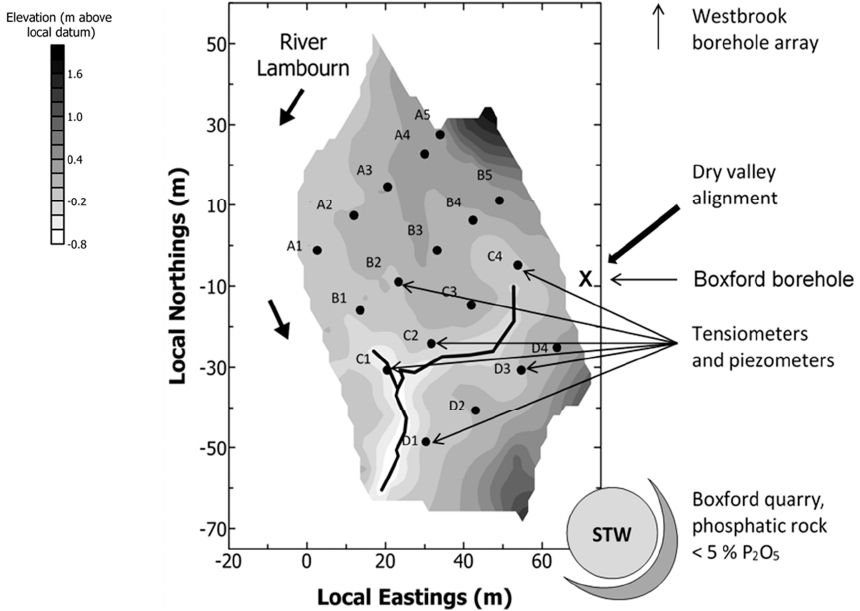
Figure 2 . Instrumentation, showing the location of the porous cup sampler nests, piezometers, and Boxford borehole. Shading shows topographic variation across the site. Boxford borehole. Shading shows topographic variation across the